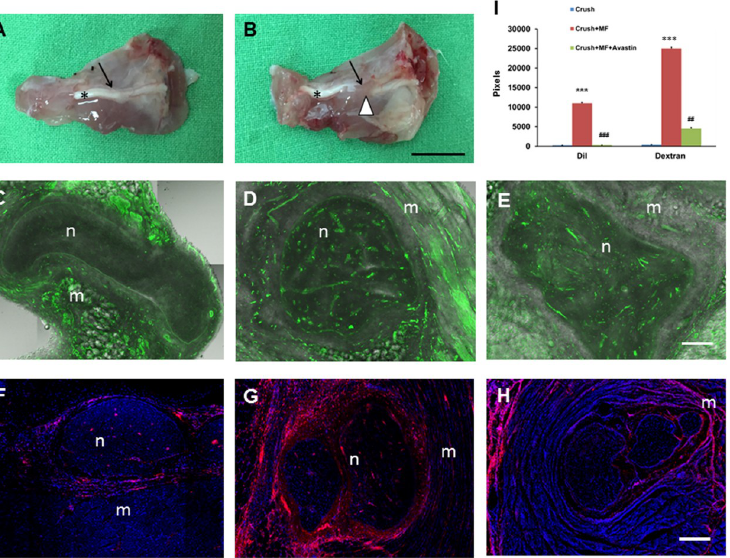
Fig 5. Representative muscle flap rotation and potential of angiogenesis results. (A) A representative nerve crush. (B) Nerve crush wrapped by the muscle. (C) Demonstration of FITC dextran infusion in the Crush group. (D) Demonstration of FITC dextran infusion in the Crush+MF group. (E) Demonstration of FITC dextran infusion in the Crush+MF+Avastin group. (F) Demonstration of DiI infusion in the Crush group. (G) Demonstration of DiI infusion in the Crush+MF group. (H) Demonstration of DiI infusion in the Crush+MF+Avastin group. (I) Quantitative analysis of FITC dextran and DiI infusion in various treatment groups. Crush, Crush+MF, Crush+MF+Avastin: see text. � p < 0.05, �� p < 0.01 indicated the Crush+MF related to Crush, # p < 0.05 indicated Crush+MF+Avastin related to Crush+MF. Black arrow bar length = 1cm; White arrow bar length = 100 μ m; Black arrow: crush site; white arrow head: muscle flap. n: center of nerve;